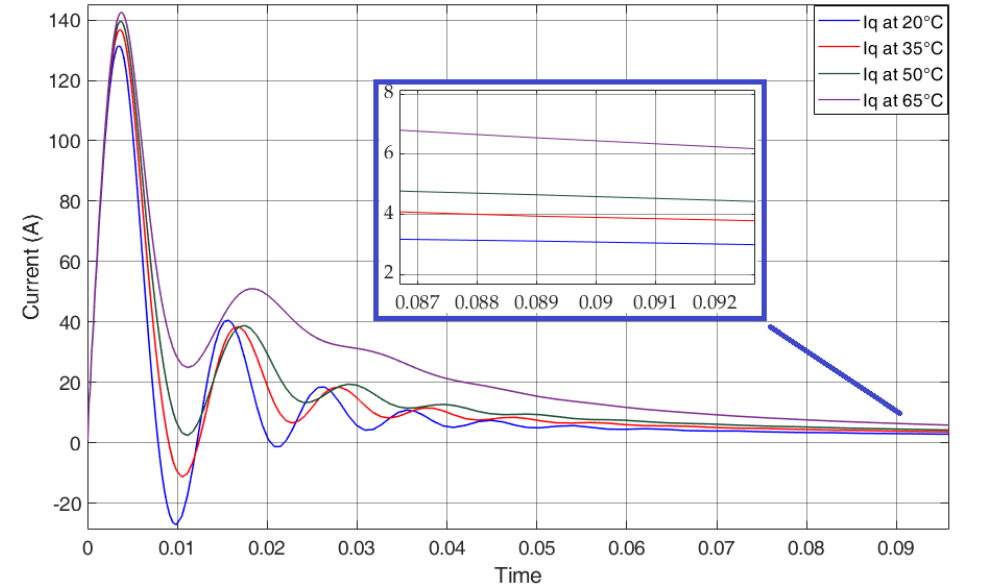
Figure 11. Stator current in q-axis varies with changes in operating temperature of IPMSM. The derivative of i qs mentioned in Equation (25) is presented in Figure 13. This estimated derivate current is of high importance, as it required as an input to estimation of permanent magnet flux linkage mentioned in Equation (33). The value of it changes until convergence of the stator current i qs . The value of derivative of current will be higher if the difference between the reference value of stator current i qs and the estimated value is greater. The efficient tracking of an STA based URED technique can be observed throughout the experimental results with the convergence error remaining close to or almost